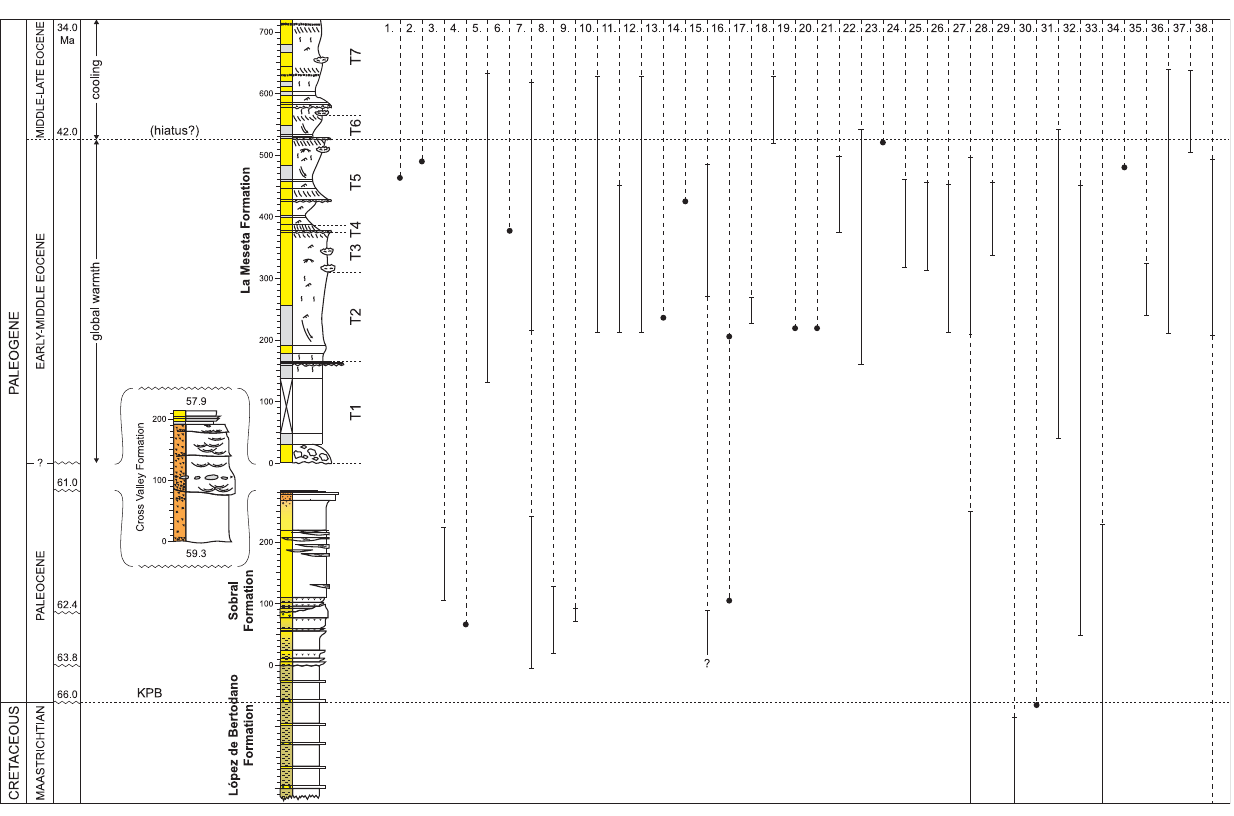
Figure 2. The fossil record of 38 modern Southern Ocean molluscan genera. Solid lines and dots depict actual fossil occurrences and ranges of 38 molluscan genera (1–26 5 gastropods, 27–38 5 bivalves). Full details as to how the occurrences and ranges were established within the stratigraphic framework are contained within the text and S2 Appendix. Klb 9 represents the topmost Maastrichtian stratigraphic unit of the LBF, KPB 5 Cretaceous/ Paleogene boundary, and (10) is Kplb 10, the recovery interval and topmost informal stratigraphic unit of the LBF. T1–7 5 Telms 1–7 of the LMF; ages (in Ma) are approximate and taken from Montes et al. [117] for the SF, CVF and topmost LMF (Telms 6–7). Further details on the age of the La Meseta Formation are given in S1 Appendix. Gastropods arranged in taxonomic order according to Bouchet & Rocroi [118]; bivalves according to Bouchet & Rocroi [119] and Taylor et al. [120]. 1. Calliotropis ; 2. Collonia ; 3. Euspira ?; 4. Amauropsis ?; 5. Falsilunatia ; 6. Sinuber ; 7. Perissodonta ; 8. Probuccinum ?; 9. cf. Germonea ; 10. Prosipho ; 11. Pareuthria ; 12. Chlanidota ; 13. Trophon ; 14. Fulgurofusus ; 15. Volutomitra ?; 16. Miomelon ?; 17. Tractolira ; 18. Aforia ?; 19. Spirotropis ?; 20. Typhlomangelia ; 21. Epitonium ; 22. Acirsa ; 23. Acteon ; 24. Neoacteonina ; 25. Tornatellaea ; 26. Kaitoa ; 27. Leionucula ; 28. Yoldia (Aequiyoldia) ; 29. Limopsis ; 30. Limatula ; 31. Cyclocardia ; 32. Parathyasira ; 33. Conchocele ; 34. Mysella ; 35. Gaimardia ; 36. Cyamiomactra ; 37. Hiatella ; 38. Thracia .